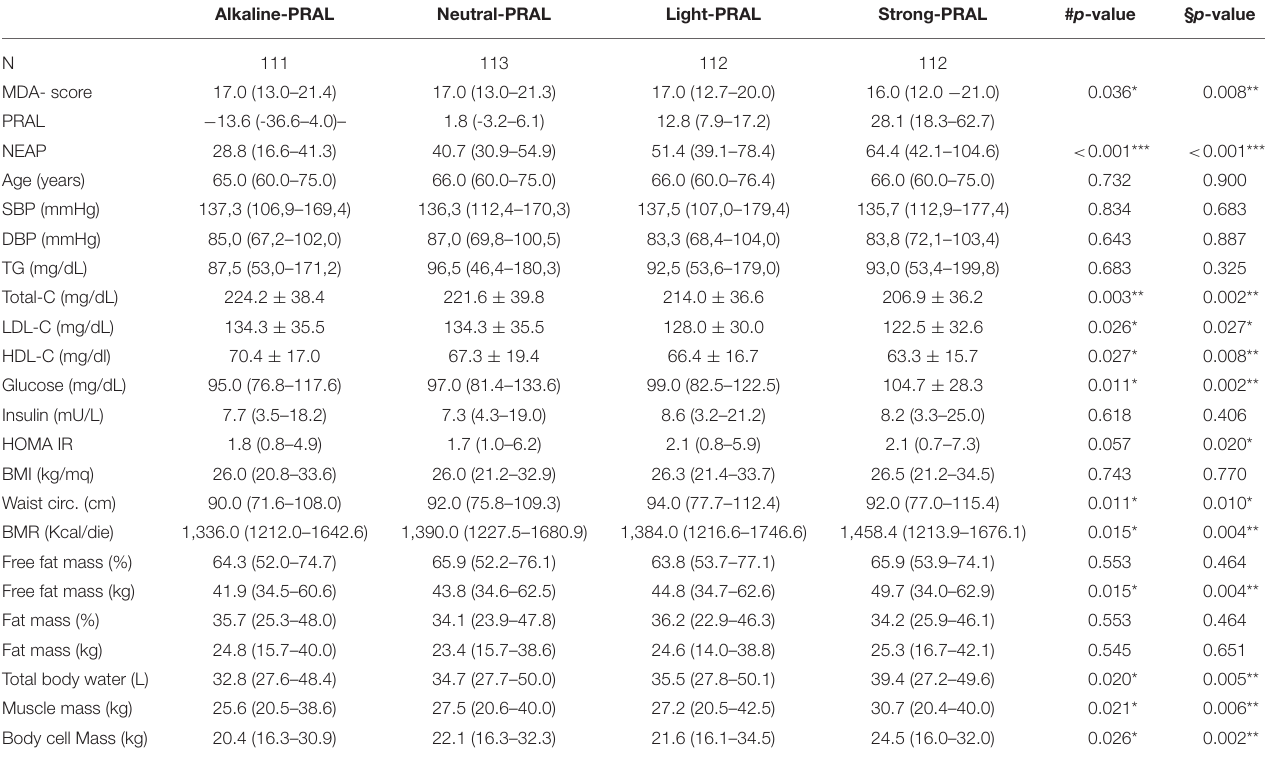
TABLE 4 | Population characteristics per PRAL quartile.